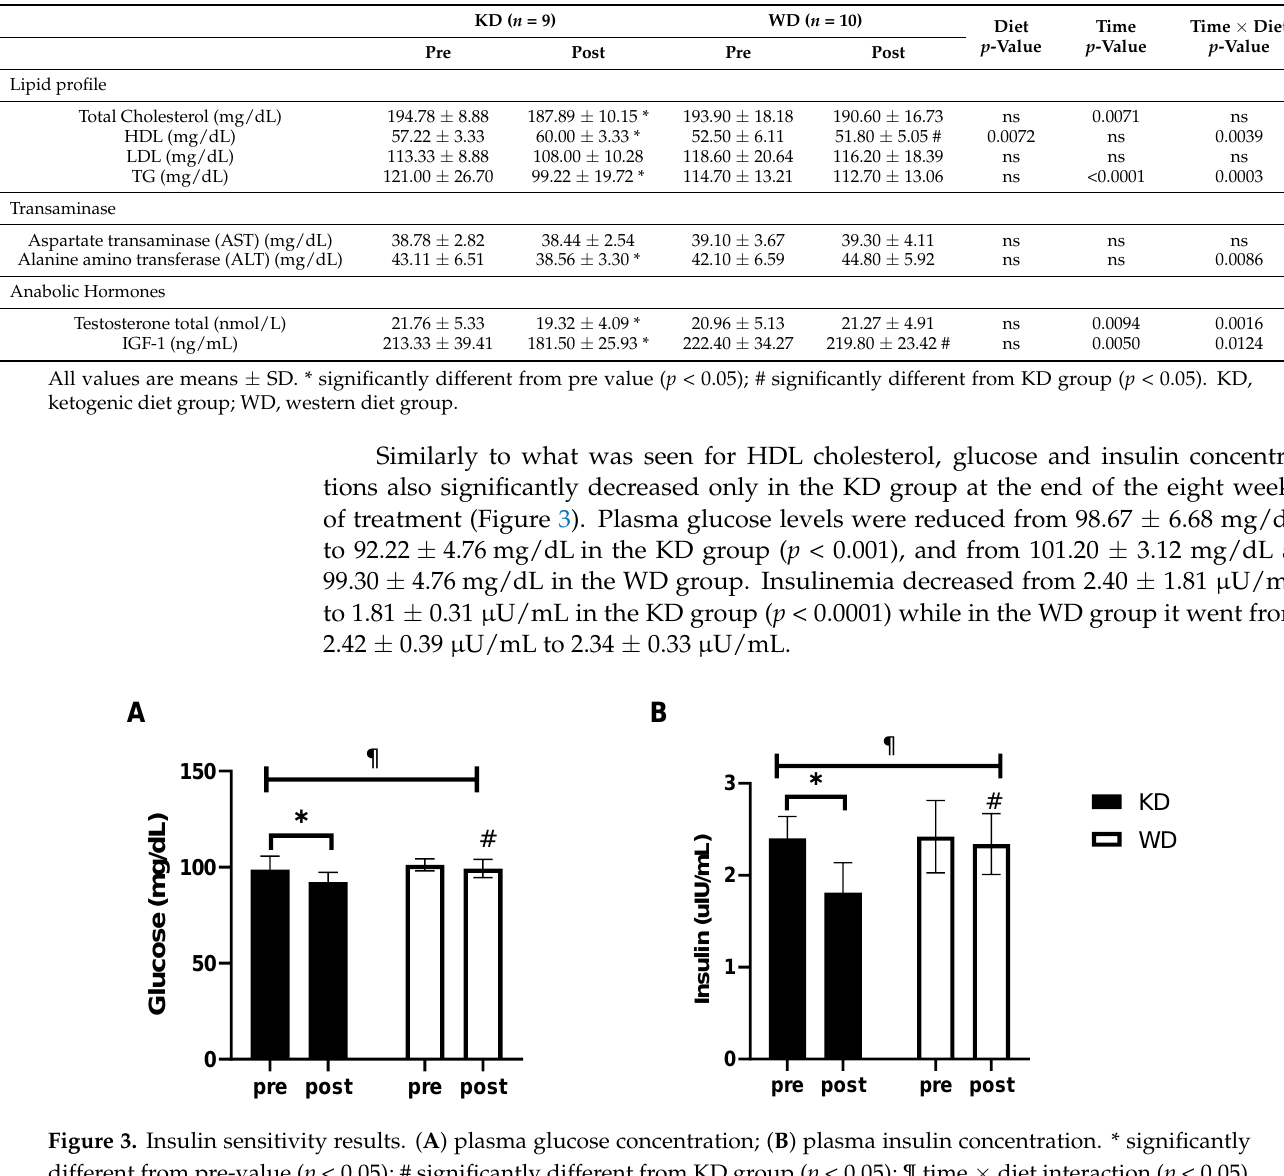
Table 4. Blood parameters.